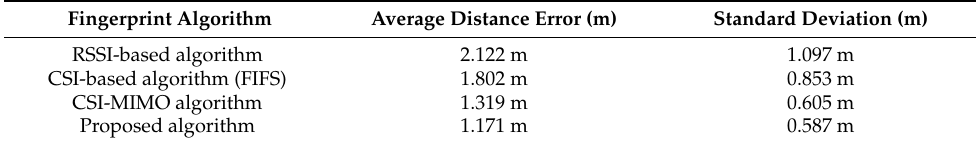
Figure 25. Comparing the CDF value of localization error of four algorithm in IT-2 building. Table 3. Comparison of four indoor fingerprint location algorithms (corridor of IT-1 building).